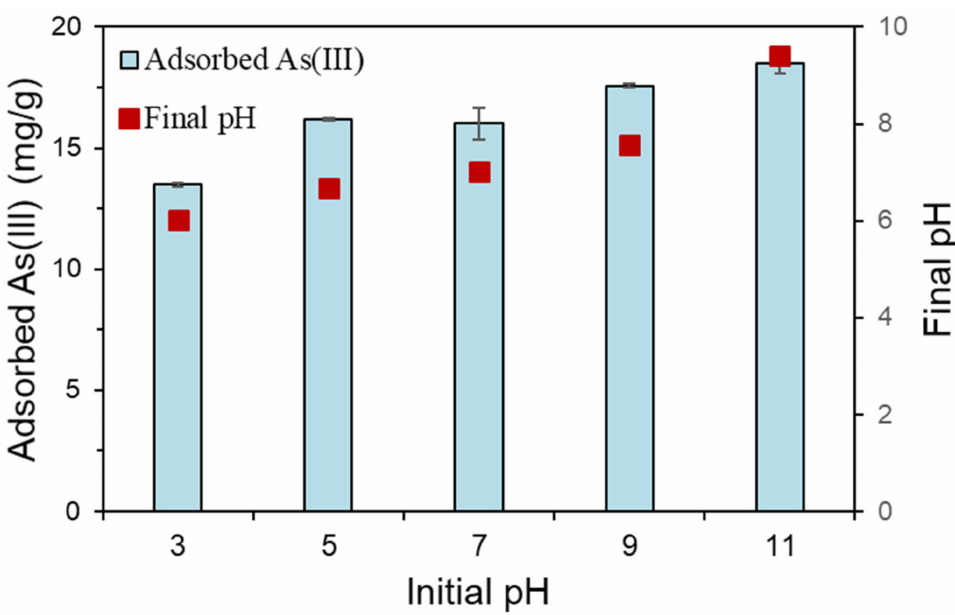
Figure 5. Effect of initial solution pH on the As(III) adsorption at 100 mg/L As(III) concentration in different pH